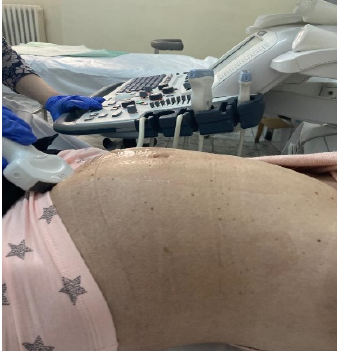
Figure 1. Abdominal distension.